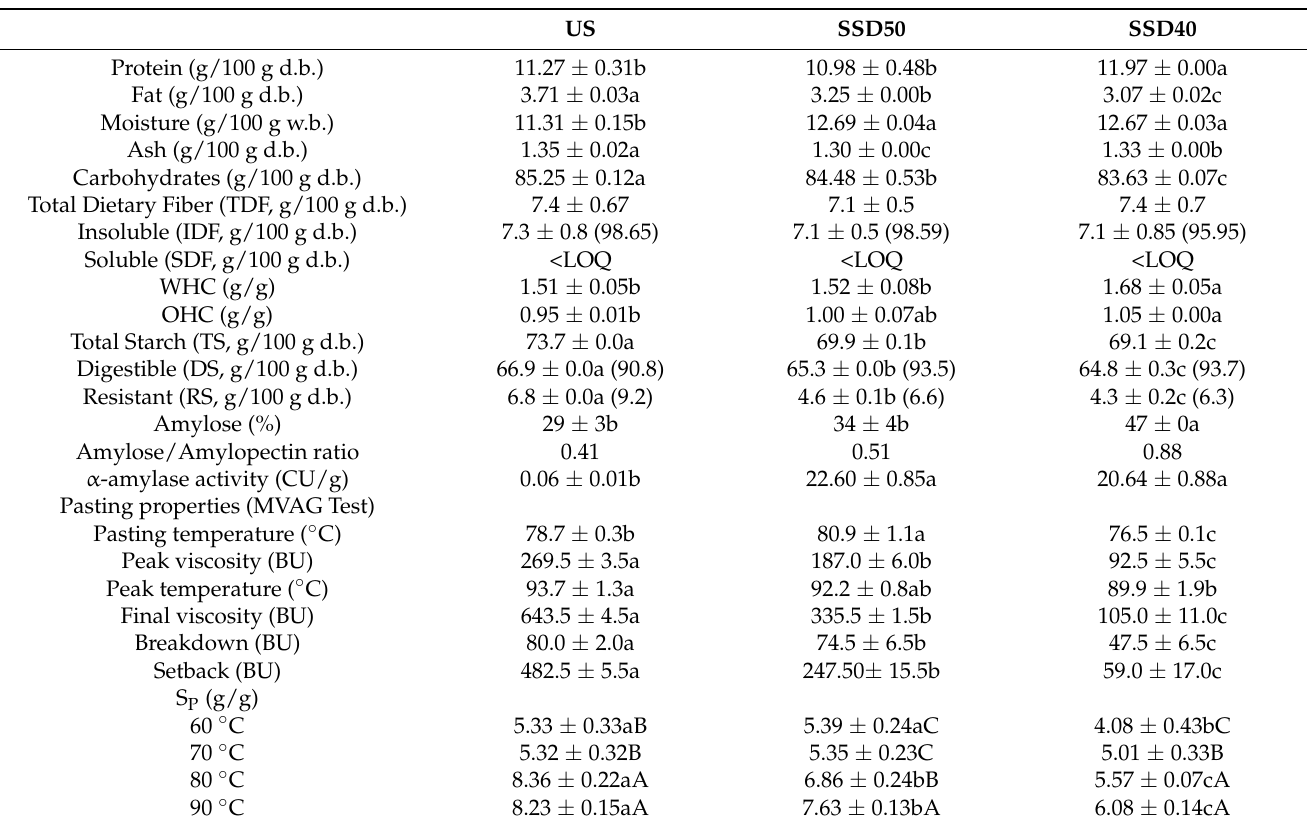
Table 1. Proximate composition, physico-chemical and pasting properties of unsprouted and sprouted sorghum flours. Compositional data are expressed as g/100 g dry basis (d.b.). In brackets, soluble dietary fiber (SDF) refers to g/100 g d.b. total dietary fiber (TDF); resistant starch (RS) and digestible starch (DS) refer to g/100 g d.b. total starch (TS). US SSD50 SSD40 Protein (g/100 g